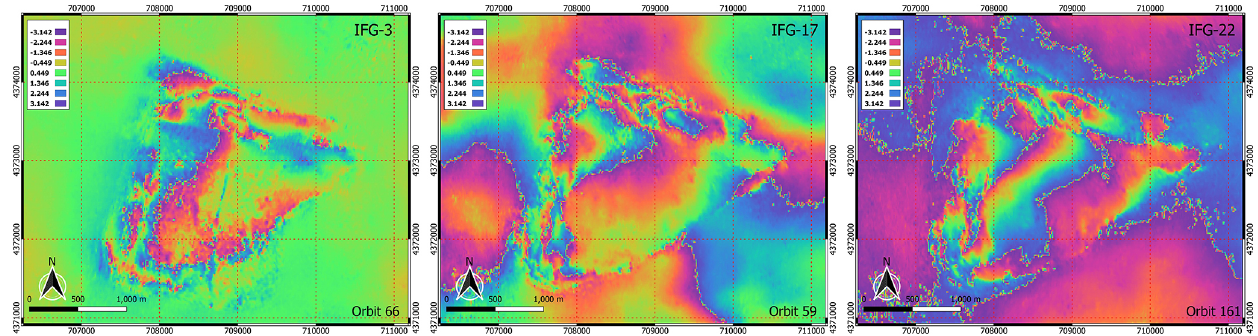
Figure 7. Detected fringes in interferograms 3, 17, and 22, with images focused on the Grarem zone.